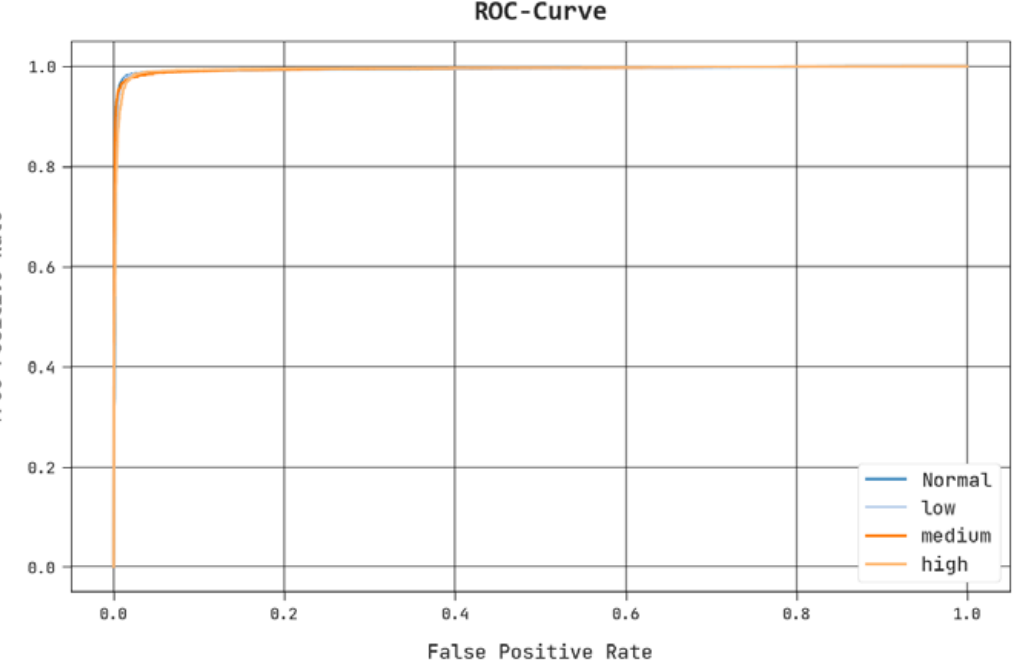
Figure 10. Precision-recall analysis of PPIE-ODLASC methodology.